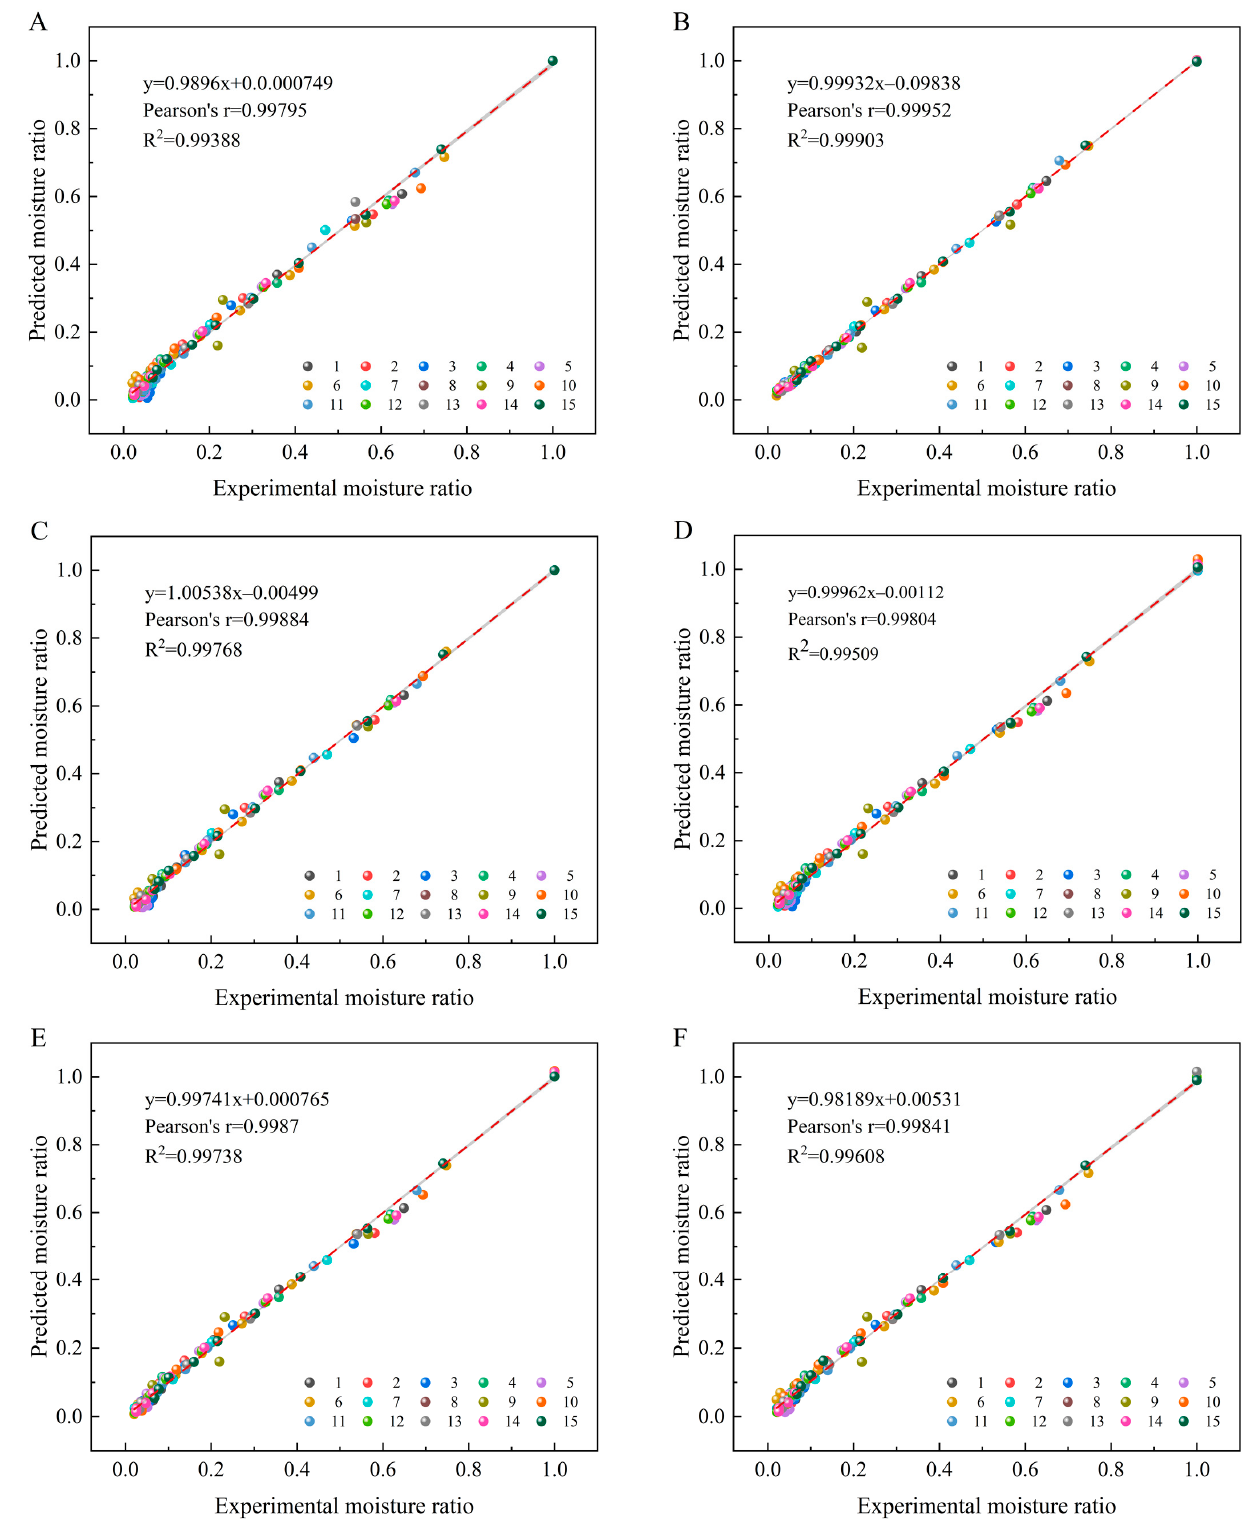
Figure 5. Experimental determined and predicted moisture ratio by Newton ( A ), Midilli ( B ), Weibull ( C ), Handerson and Pabis ( D ), Logarithmic ( E ) and Two-term exponential ( F ) model with different drying conditions.